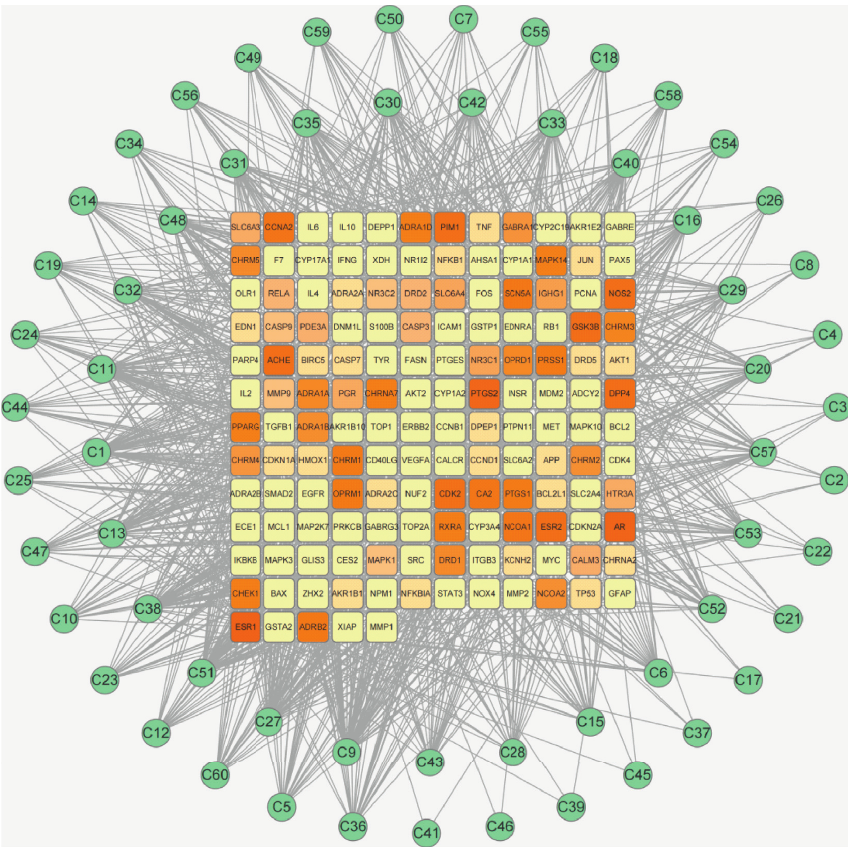
Figure 1: Compound-target